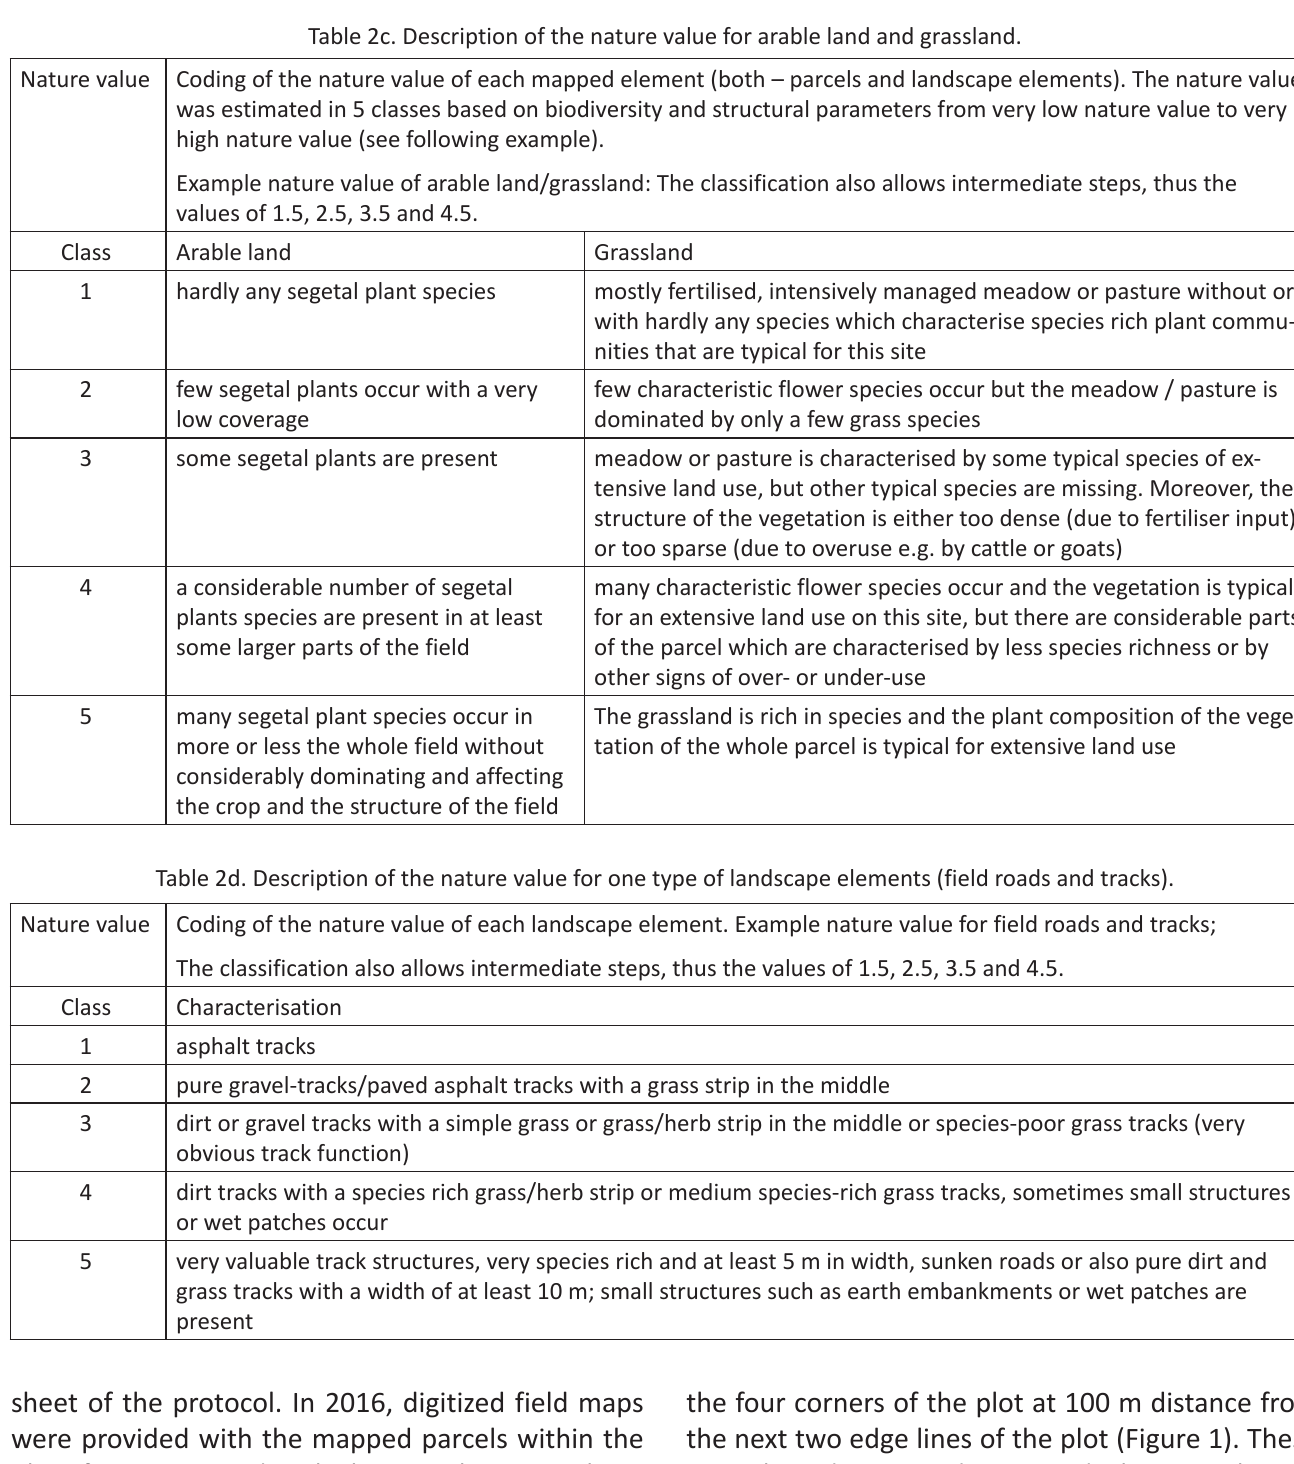
Figure 2. Schematic representation of the workflow in